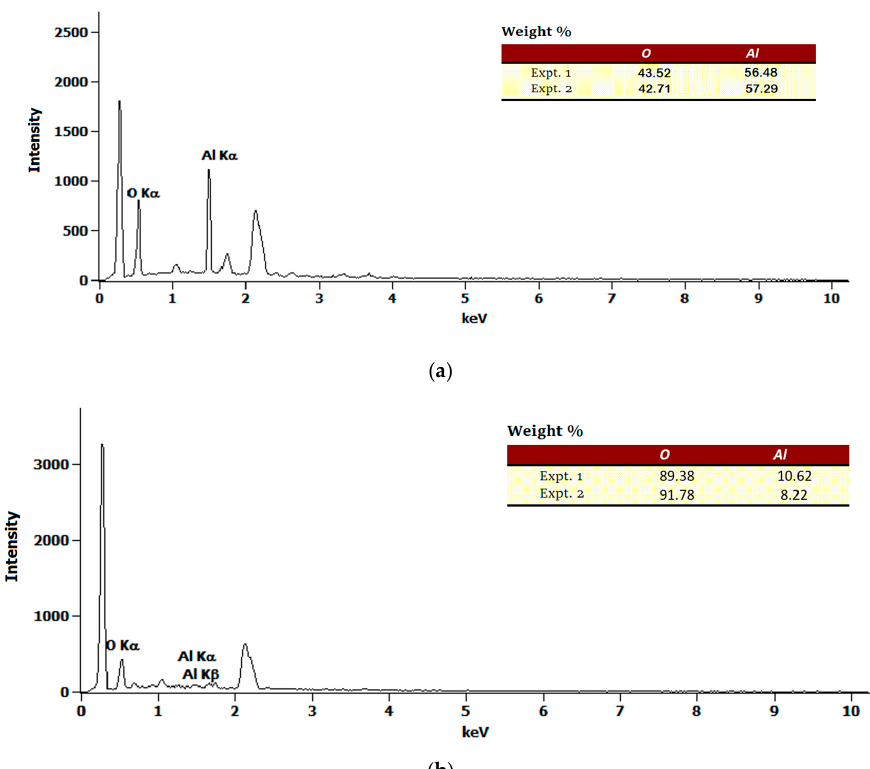
Figure 4. ( a ) energy dispersive X-ray (EDX) spectra of Al 2 O 3 nanoparticles and ( b ) EDX spectra of PVA-Al 2 O 3 (10 wt%).